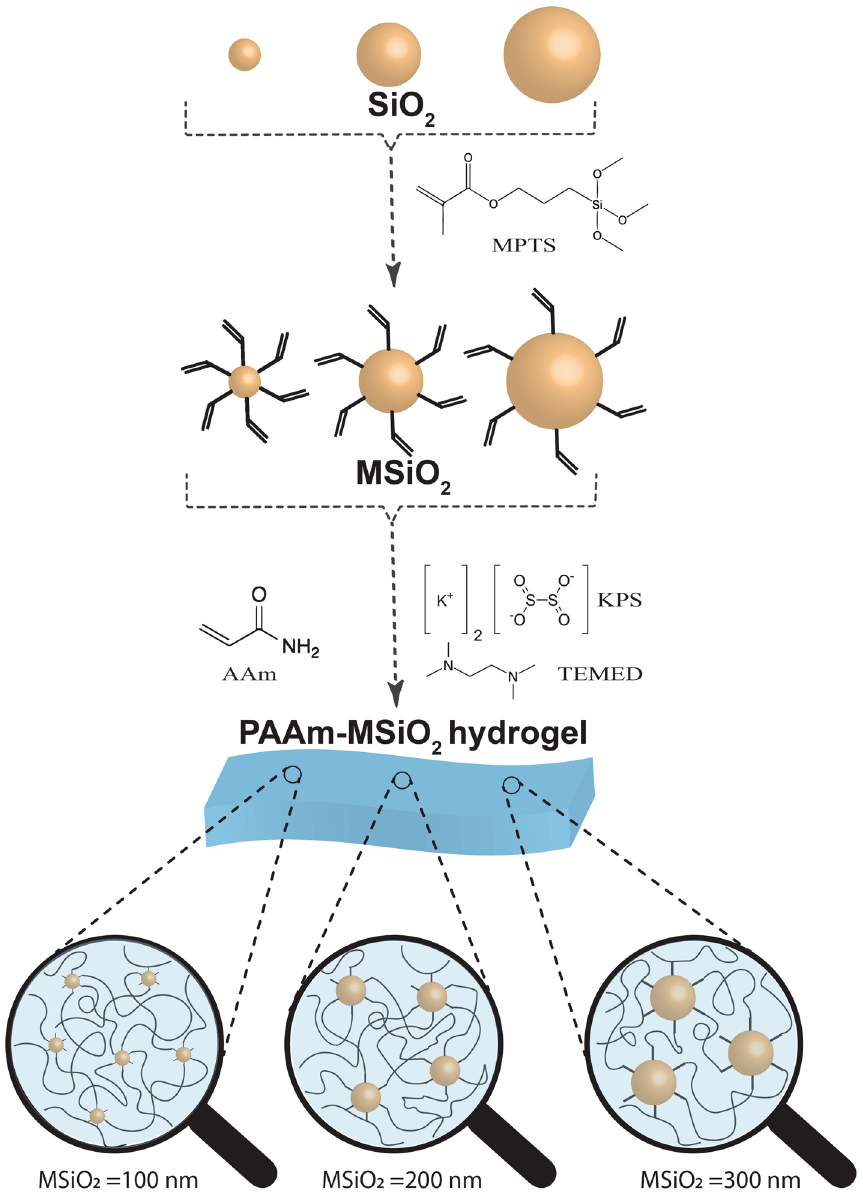
Figure 1. Schematic representation of the fabrication of PAAm-MSiO2 hydrogel prepared by varying particle sizes of MSiO 2 (100 nm, 200 nm, 300 nm)